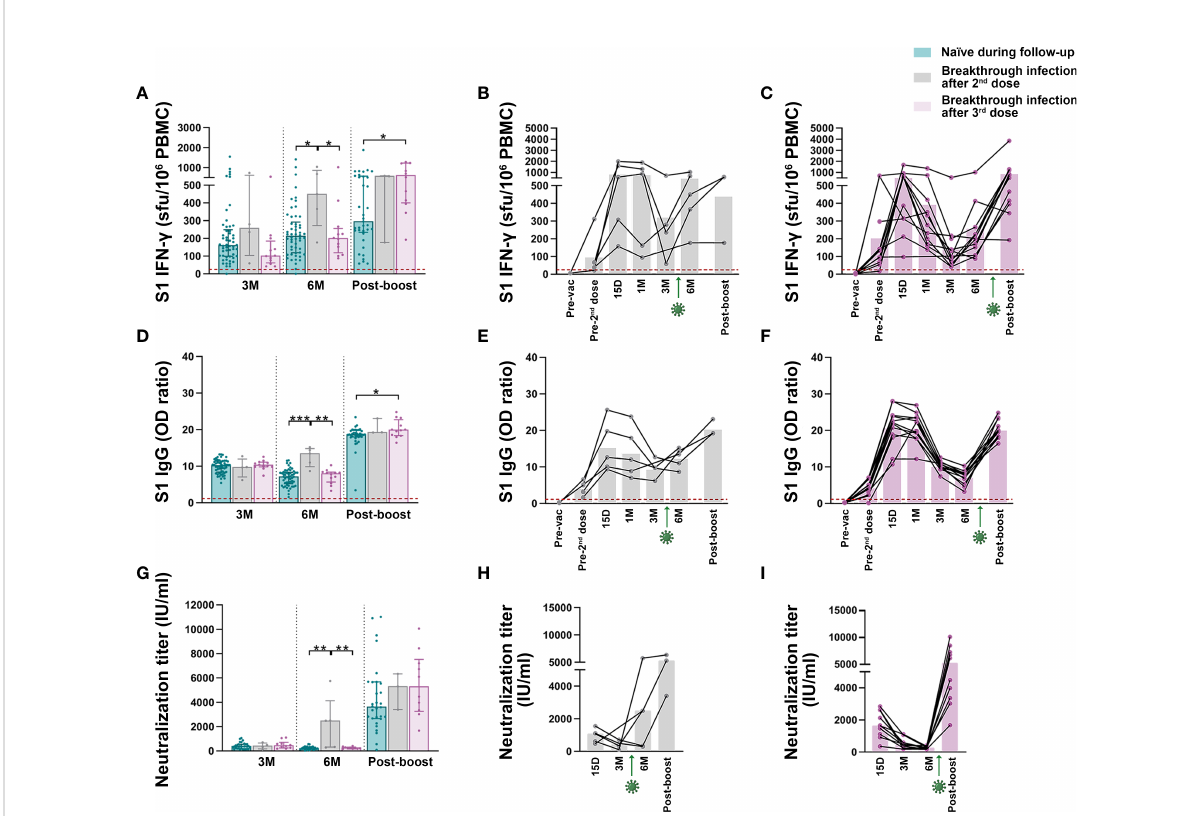
FIGURE 3 Effect of breakthrough infections on existing SARS-CoV-2 immunity. (A) Comparison of S1-IFN- g -producing T cells among naïve individuals who remain naïve (in blue) and those with breakthrough infections after 2 nd (in grey) and 3 rd dose (in purple). Out of the 5 subjects who had SARS- CoV-2 infection after the 2 nd dose only 3 subjects received the third vaccine dose. (B, C) Longitudinal data on the dynamics of speci fi c T cells in the 5 subjects infected by SARS-CoV-2 after the 2 nd dose (B) and in the 12 individuals infected after the 3 rd dose (C) . (D) Comparison of anti- S1IgG levels among SARS-CoV-2 naïve individuals and breakthrough infections after 2 nd and 3 rd dose. (E, F) Dynamics of antibody levels in subjects infected after the 2 nd (E) and the 3 rd dose (F) . (G) Comparison of neutralizing activity among SARS-CoV-2 naïve individuals and breakthrough infections after 2 nd and 3 rd dose. (H, I) Neutralizing activity in SARS-CoV-2 infected subjects after the 2 nd (H) and the 3 rd dose (I) . Green arrows represent the time of SARS-CoV-2 infection. Dashed lines represent the positivity cut-off. The signi fi cance between groups was determined using Mann Whitney test, *p<0.05, **p<0.01, ***p<0.001. (See Figure 1 footnote for more detailed